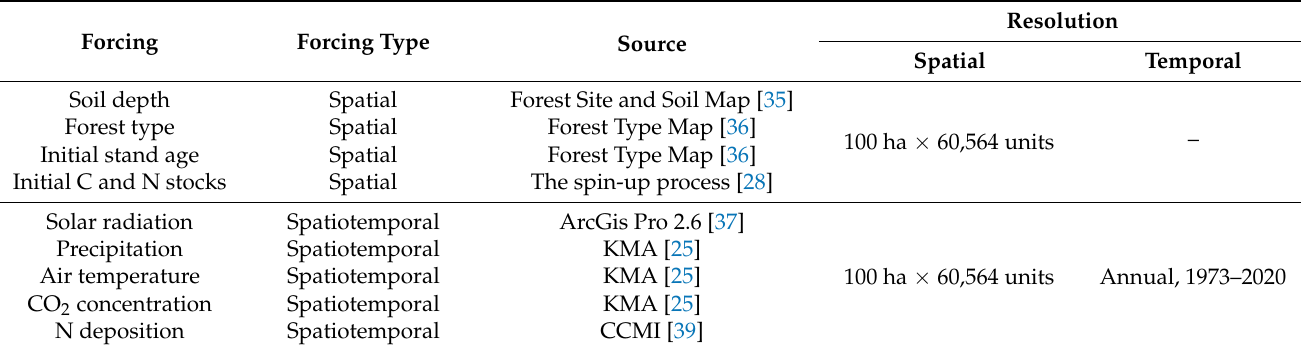
Table A1. Detailed information of forcings for the simulation.